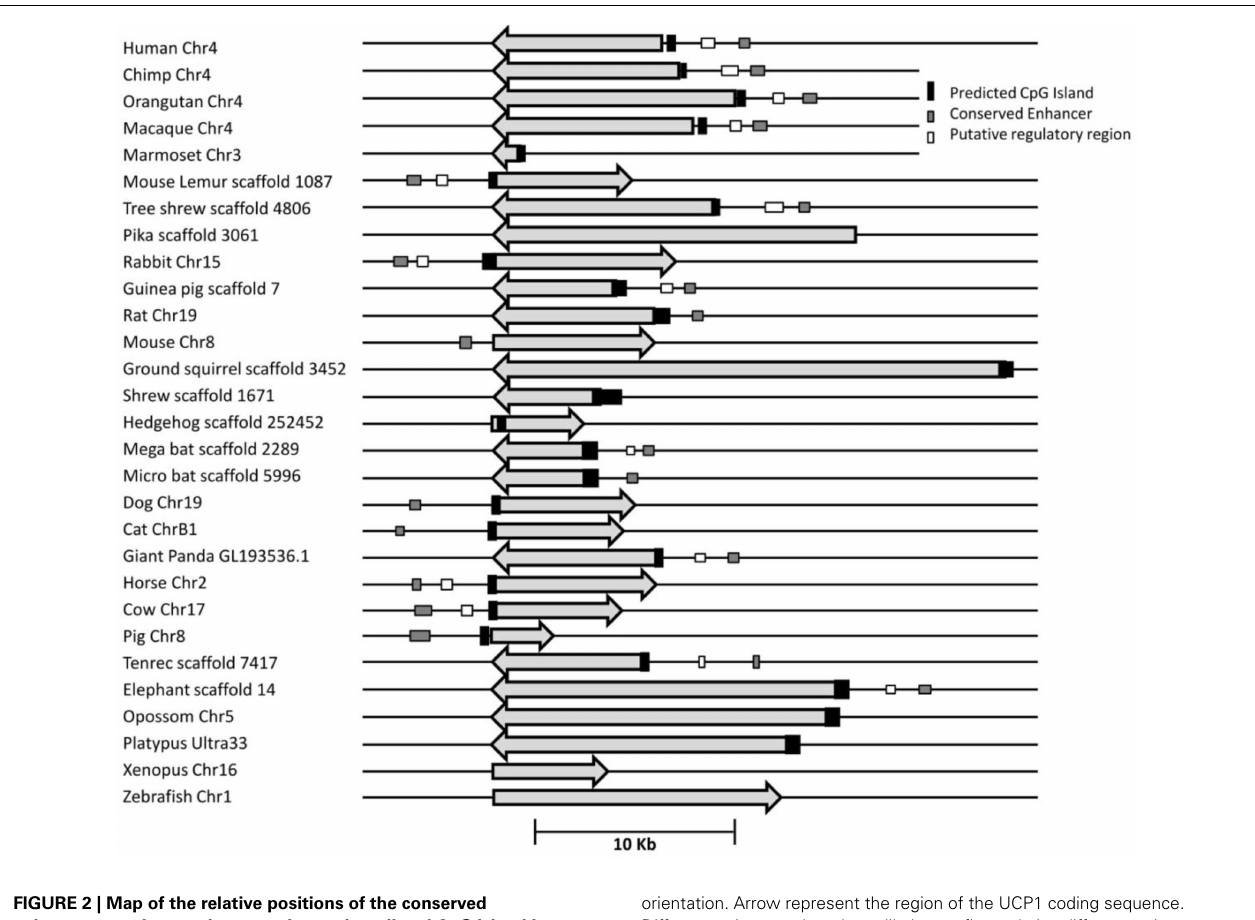
FIGURE 2 | Map of the relative positions of the conserved enhancer, putative regulatory region and predicted CpG island in the UCP1 promoter of 29 species. All genes are shown in 5 (cid:48) –3 (cid:48)